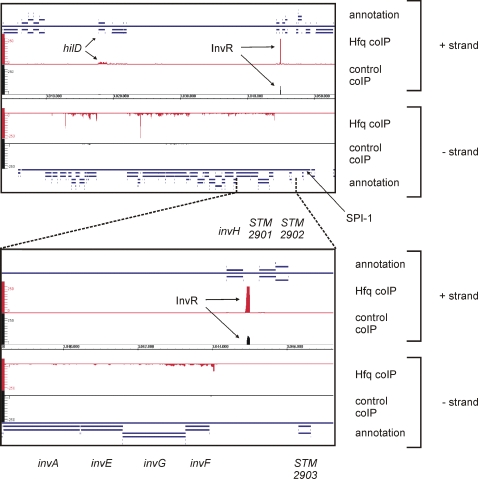
Visualization of pyrosequencing data for the Salmonella pathogenicity island 1 (SPI-1) with the Integrated genome Browser (Affymetrix).The upper panel shows an extraction of the screenshot of the Integrated Genome Browser, with the mapped Control and Hfq cDNAs of the SPI-1 region. Shown are the annotations for the “+” and “–” strand (blue), the cDNA sequence distribution from the Hfq coIP for the “+” and “–” strand (red), the cDNA-clone distribution for the control coIP for the “+” and “–” strand (black), and the genome coordinates in the center for the entire SPI-1. The annotation for SPI-1 and the Hfq coIP peaks for hilD and the sRNA InvR in the Hfq coIP are indicated. Note, that the clone numbers per nucleotide are scaled to a maximum of 250 for the Hfq and the control coIP, which truncates the high peak for InvR in the Hfq coIP library (>3000 cDNAs). The lower panel shows a close up of the invR locus and its adjacent genes.